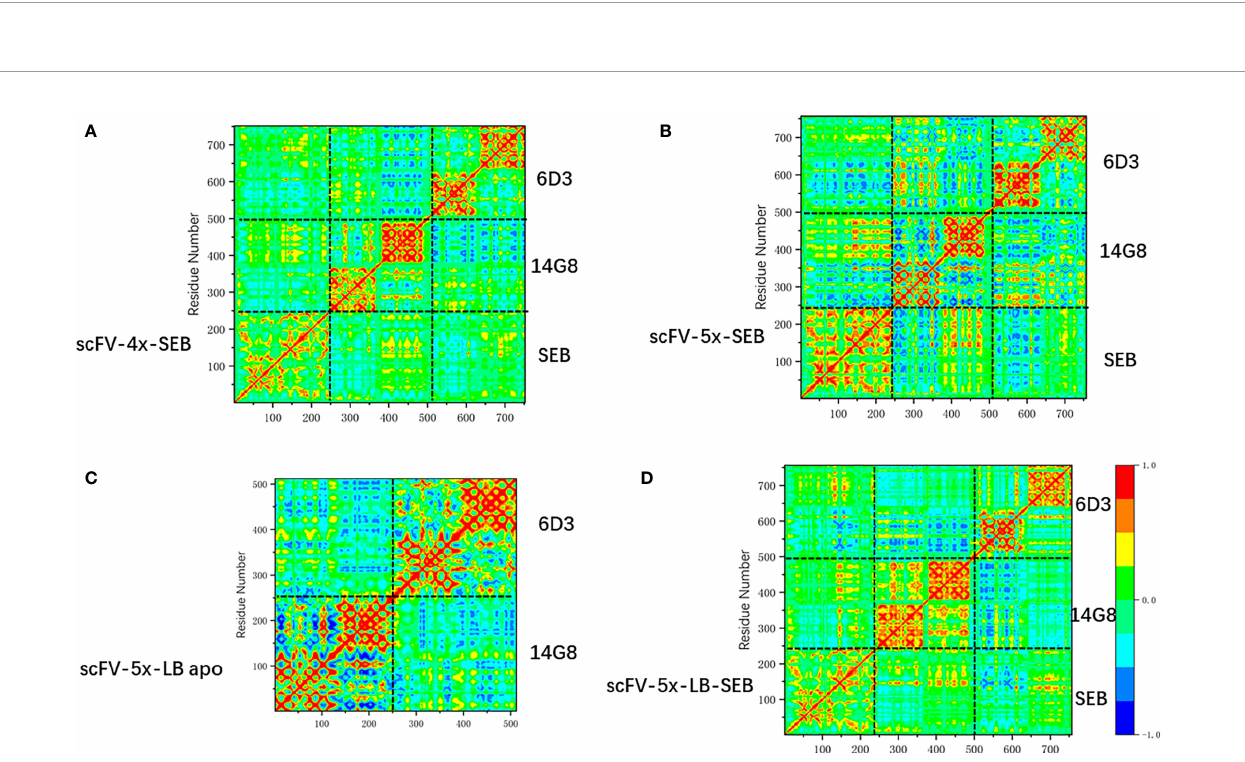
FIGURE 8 | The change of covariance matrix scFVs with different linkers. Red (blue) color corresponds to positive (negative) correlation in which residues move in the same (opposite) direction. (A) scFV-4x-SEB complex. (B) scFV-5x-SEB complex. (C) scFV-5x-LB in isolated state. (D) scFV-5x-LB-SEB